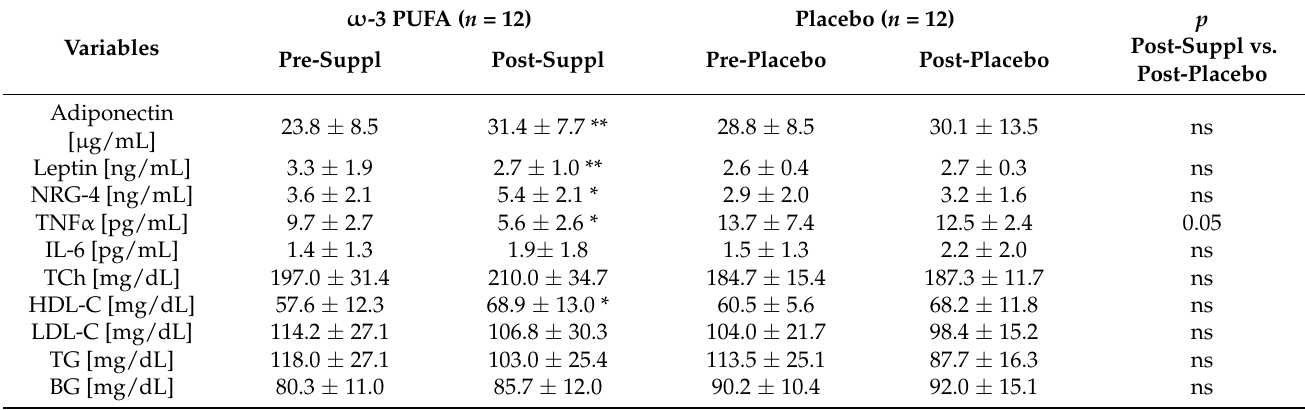
Table 4. Adipocytokines, cytokines and lipid serum concentrations in the supplemented group ( ω -3 PUFA) and placebo group (Placebo) (mean, SD).